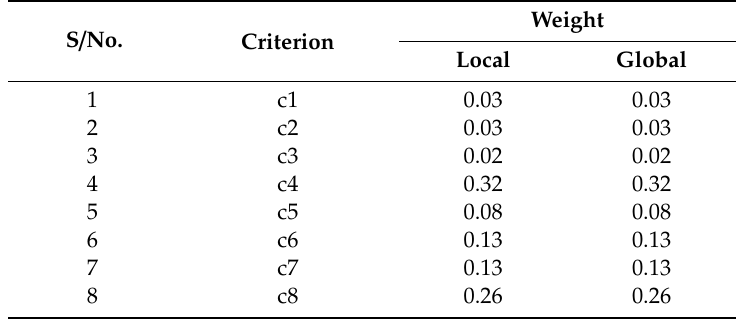
Table A4. Criteria weights by aggregate of all evaluators for technological barriers. S /